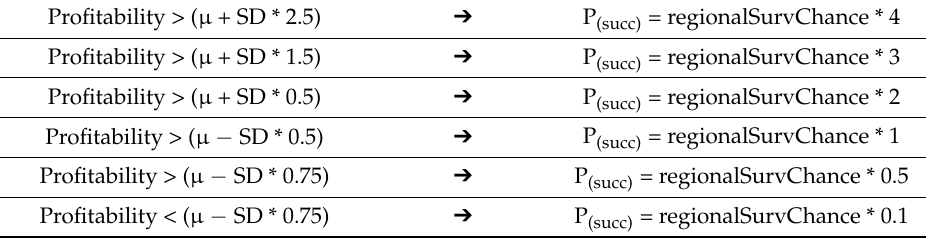
Figure 7. Relation between average standard gross margins (SGM) and average farm size for cropland (left) and dairy farming (right) in Belgium on the municipality level. Table 3. Relation between the profitability and the succession probability.